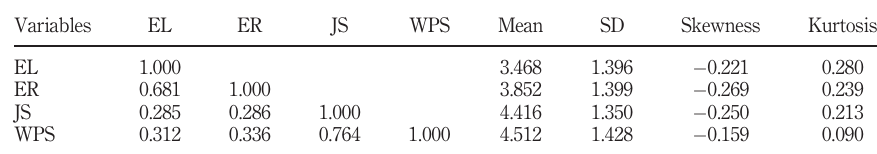
Table 3. Correlation matrix